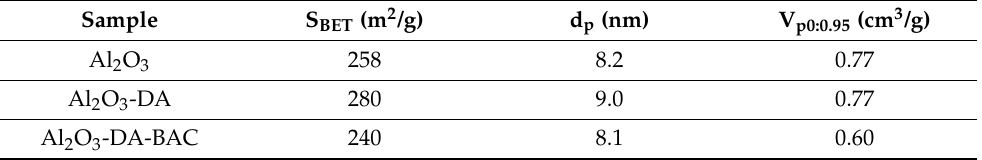
Table 1. Surface area parameters obtained for the functionalized particles and the control (Al 2 O 3 ).